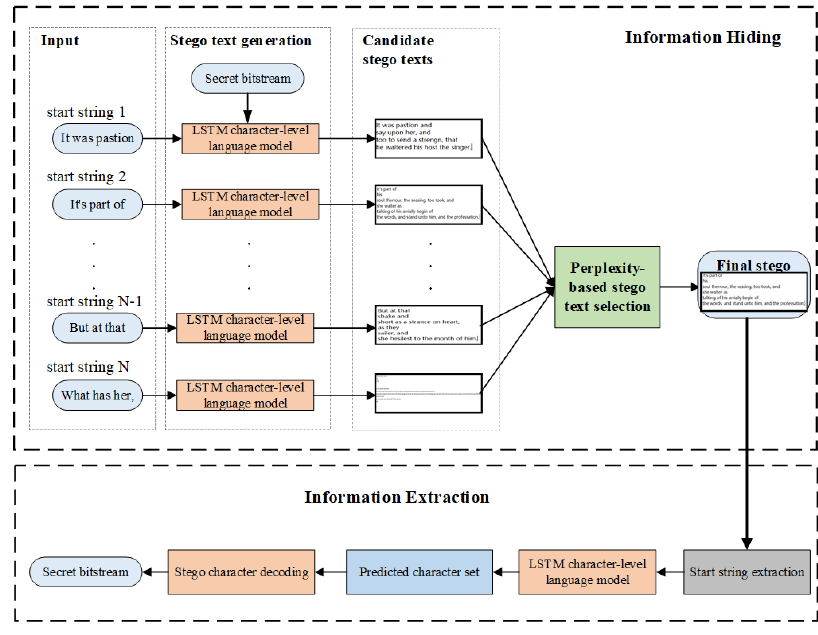
Figure 2. The framework of our proposed linguistic